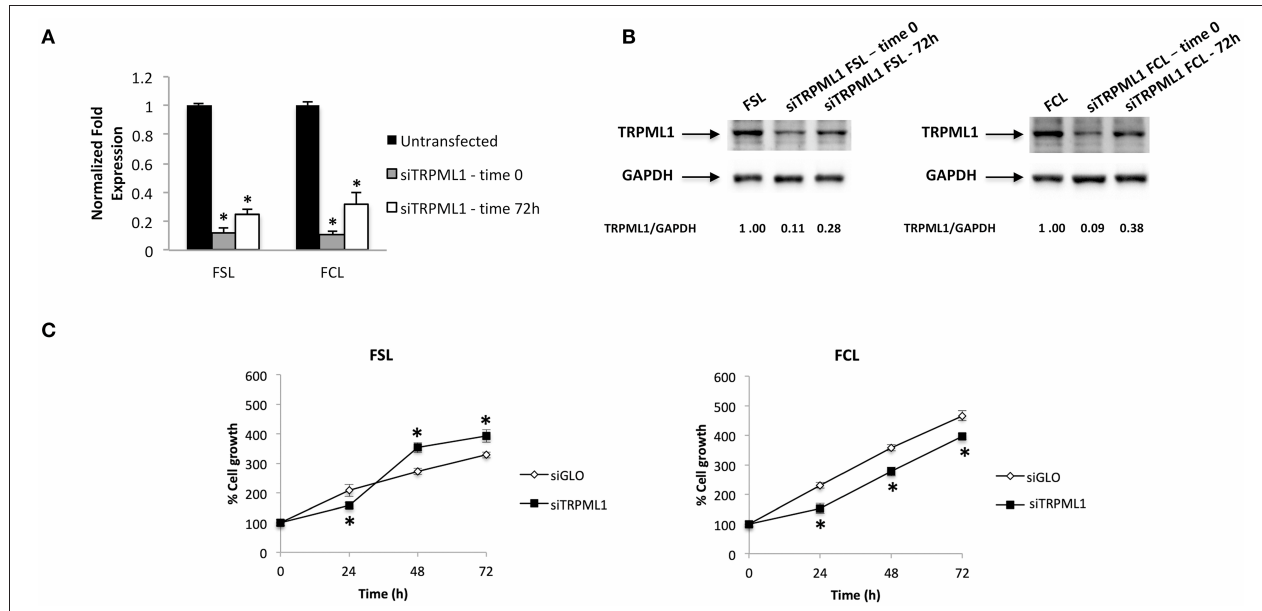
FIGURE 8 | Transient receptor potential mucolipin 1 (TRPML1) silencing affects viability of patient-derived cells. (A) The relative TRPML1 mRNA expression in untransfected and siTRPML1 FSL and FCL glioma cell lines after 72 h of silencing (time 0) and after 72-h post-transfection was evaluated by the quantitative reverse transcription (qRT)-PCR. TRPML1 mRNA levels were normalized for glyceraldehyde-3-phosphate dehydrogenase (GAPDH) expression. Data are expressed as mean ± SD; * p < 0.001. (B) Western blot analysis of TRPML1 protein levels. Blots are representative of one of three separate experiments. TRPML1 densitometry values were normalized to GAPDH used as loading control. The TRPML1 protein levels of silenced samples were determined with respect to TRPML1 levels of untransfected cells. (C) Cell viability was evaluated by the MTT assay in siGLO control and in siTRPML1 FSL and FCL glioblastoma cells for up to 72h. Data shown are expressed as mean ± SE of three separate experiments. * p < 0.01 siTRPML1 vs.